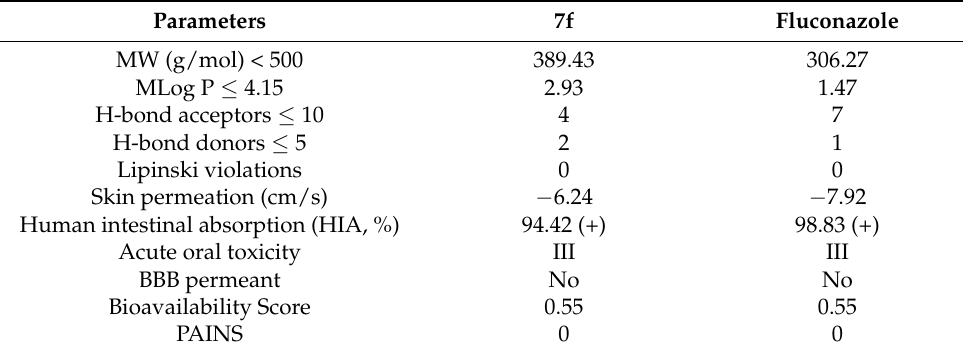
Table 2. The ADME data 1 of thioether benzimidazole 7f and fluconazole.